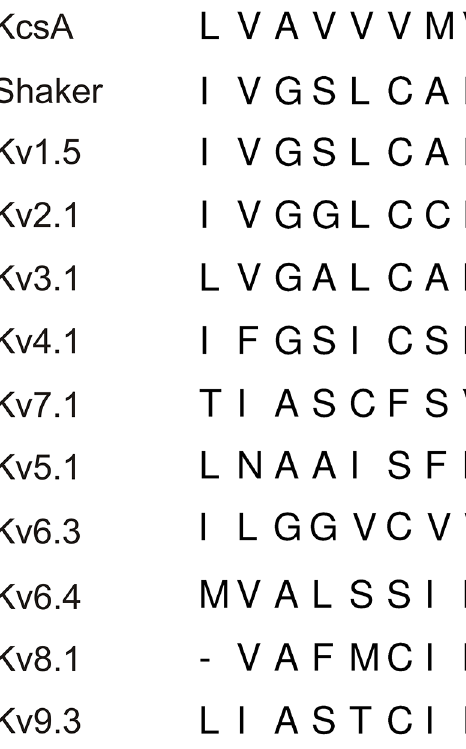
PLOS ONE | DOI:10.1371/journal.pone.0141349 October 27,